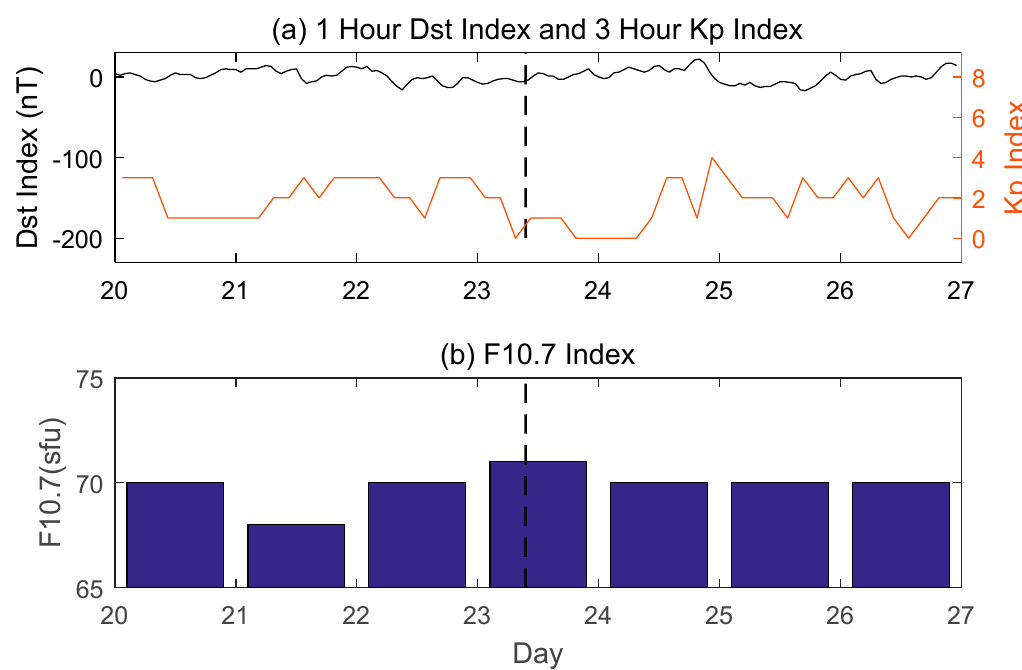
Figure 3. The geomagnetic index Dst, Kp and solar activity index F10.7 for the week around the Alaska earthquake on 23 January 2018. The dotted lines indicate the time of the earthquake.